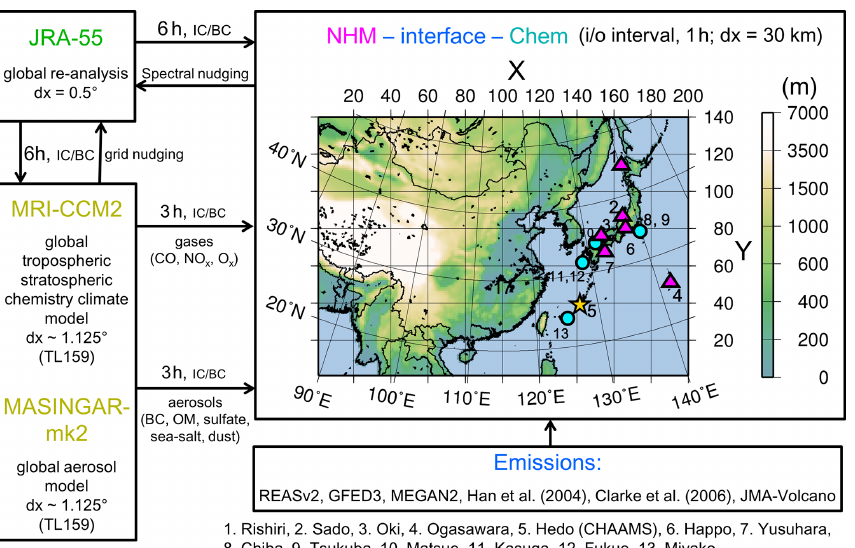
Figure 2. Current simulation settings, model domain showing terrestrial elevation (m), and observation sites. The pink triangles numbered 1–7 show the Japanese EANET sites, except site 5. Hedo (CHAAMS) is marked as the yellow star, where the SKYNET and AD-Net Hedo sites are located on the same premises. The blue circles numbered 8–13 indicate the SKYNET or AD-Net sites in